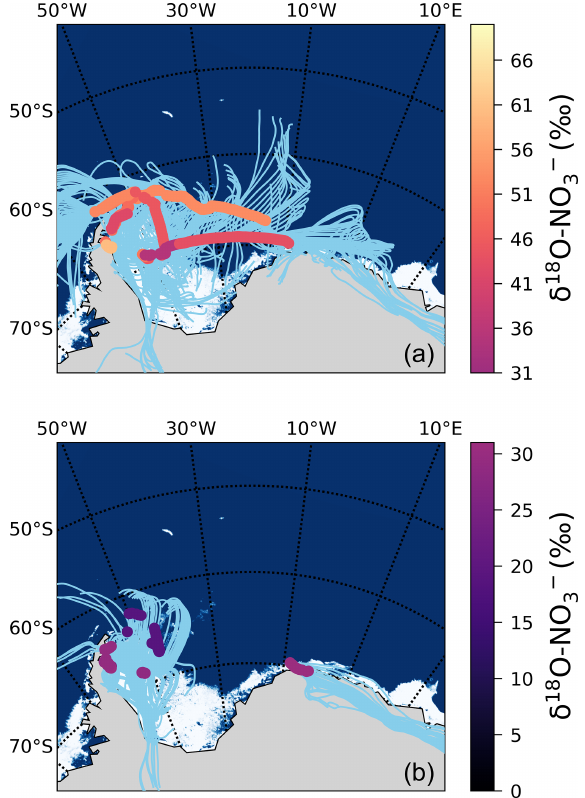
Figure 6. The 72h AMBTs (light blue lines) computed for each hour of the voyage in the Weddell Sea, when the HV-AS was op- erational for more than 45min of the hour. The vertical colour bar represents the weighted average δ 18 O of atmospheric nitrate ( δ 18 O– NO − ), where δ 18 O–NO − was > 31‰ (a) and < 31‰ (b) . The 3 3 white area represents the location of the sea ice (see Fig. 2